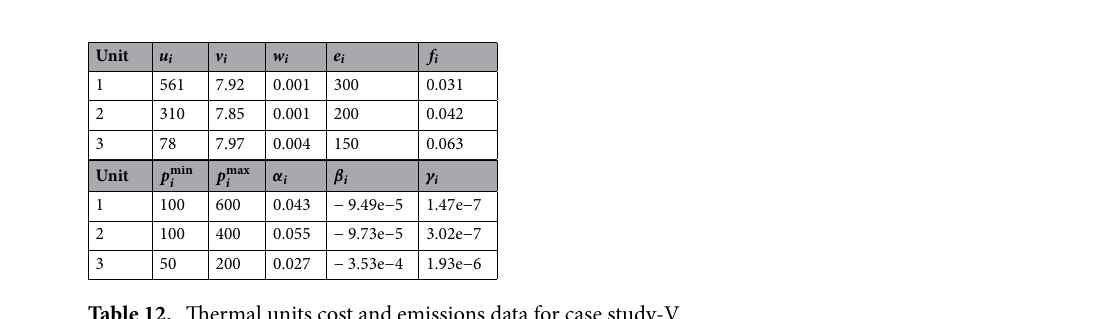
Figure 14. ABWO performance for case study-IV.